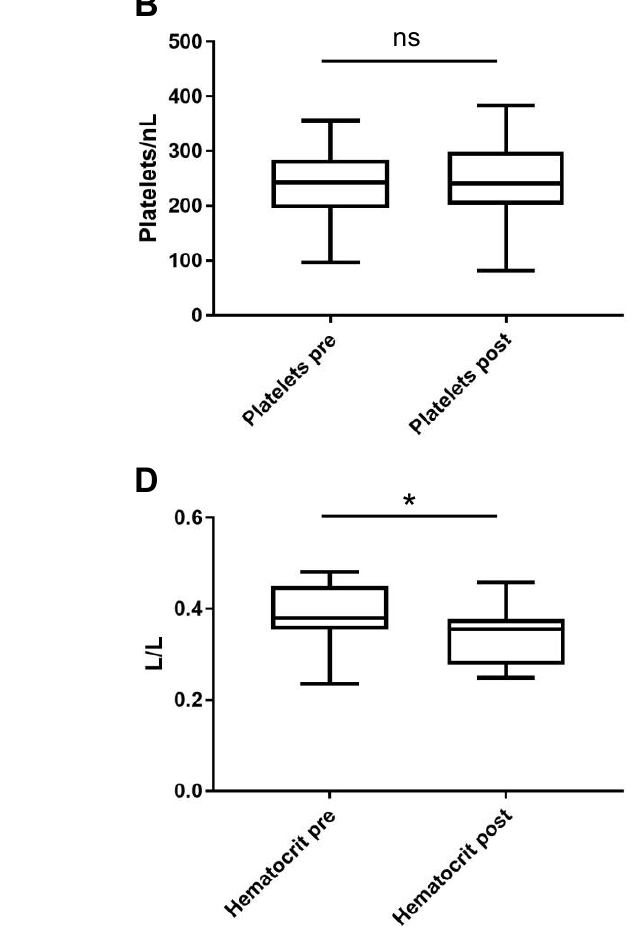
Figure 3. Levels of ( A ) white blood count (WBC), ( B ) platelets, ( C ) hemoglobin, and ( D ) hematocrit, before (pre) and after (post) total plasma exchange. Boxplots show medians and minima to maxima. ns = not significant. * = p < 0.05.